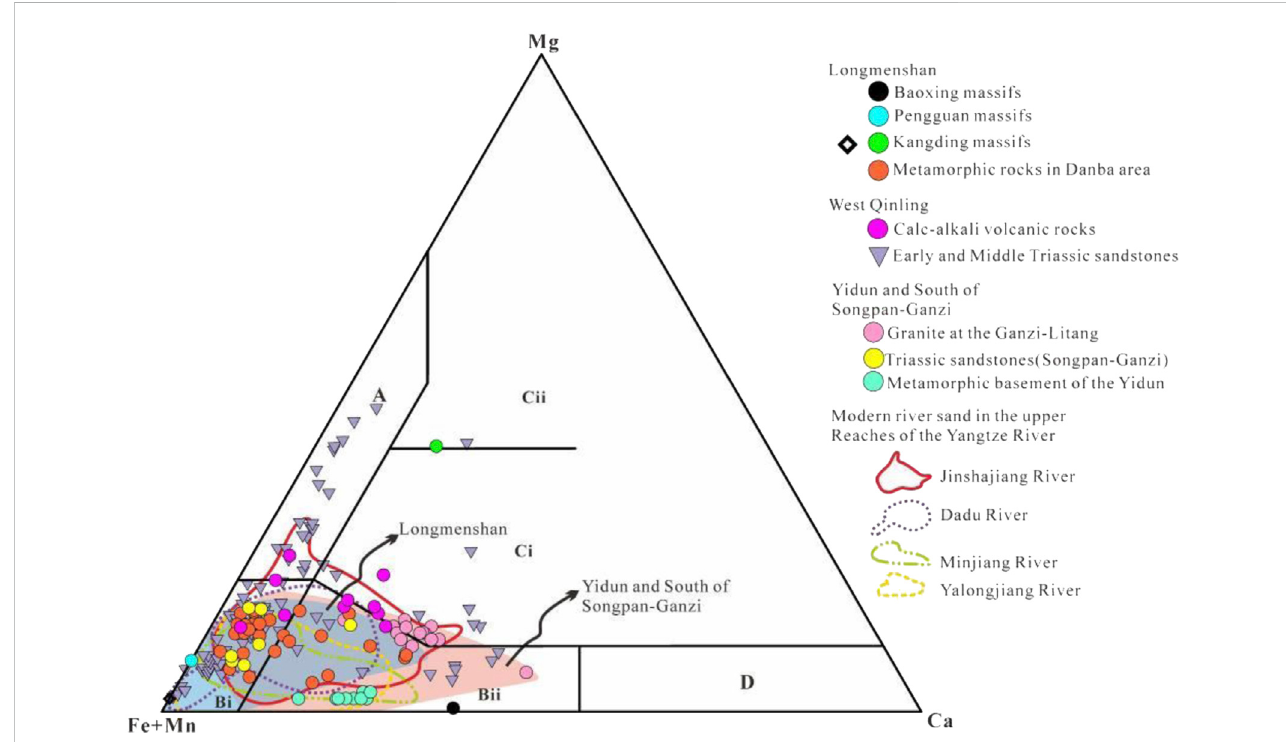
FIGURE 12 The G-P-AS triangular diagram (Mange and Morton, 2007) of garnet geochemistry from literature. Garnet geochemistry data form the Triassic fl ysch fromthesouthernSongpan-Ganzi(Zhangetal.,2008),EarlyandMiddleTriassicsandstonesintheWestQinling(Yanetal.,2014),TriassicgraniteoftheGanzi- Litangsuturezone(Lietal.,2017),MetamorphiccrystallinebasementofYidunTerrane(Tianetal.,2018),MetamorphicmassifsinLongmenshan orogenicbelt (He et al., 1988), Metamorphic rocks in Danba area of the southeast corner of Tibetan Plateau (Huang et al., 2003; Billerot et al., 2017), and garnet from modern river sands in the upper Reaches of the Yangtze River (Wang et al.,